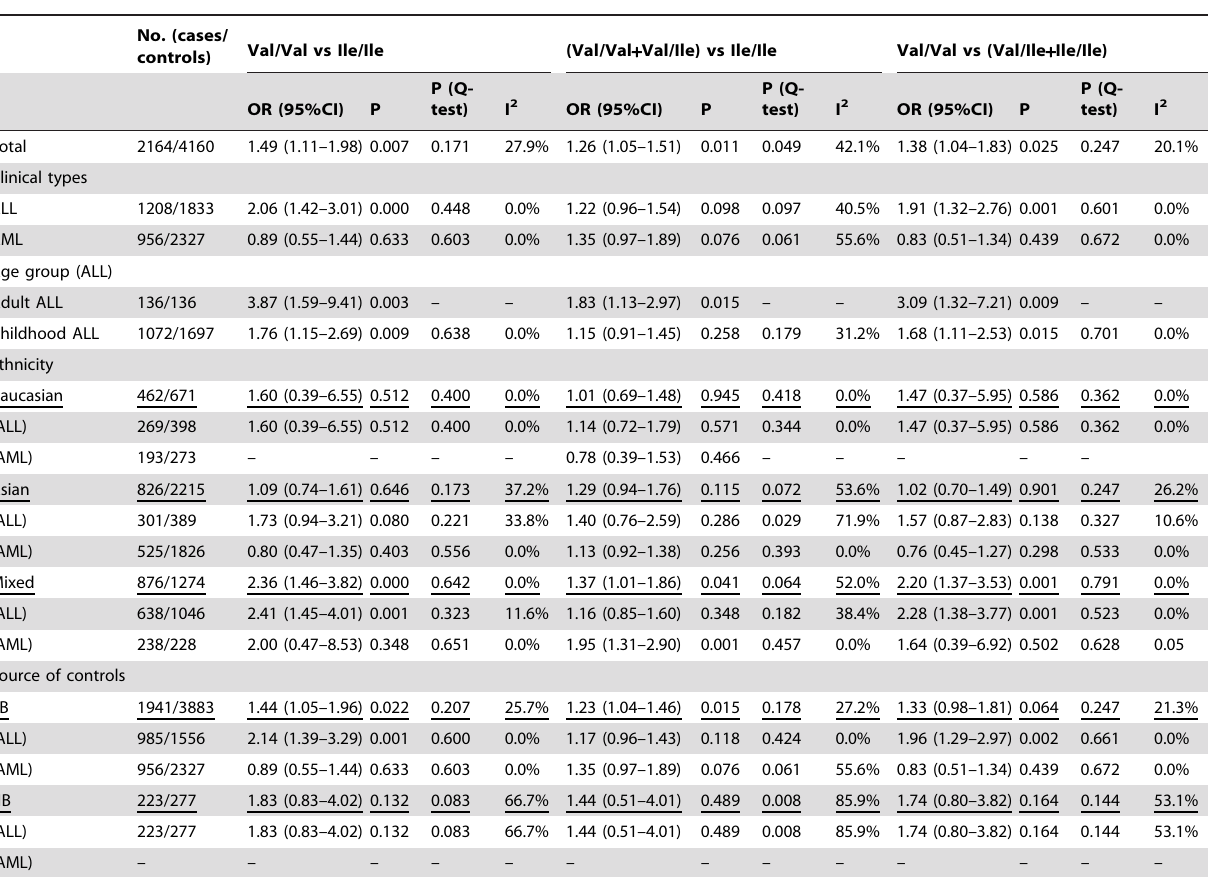
Table 3. Main results of the pooled data in the